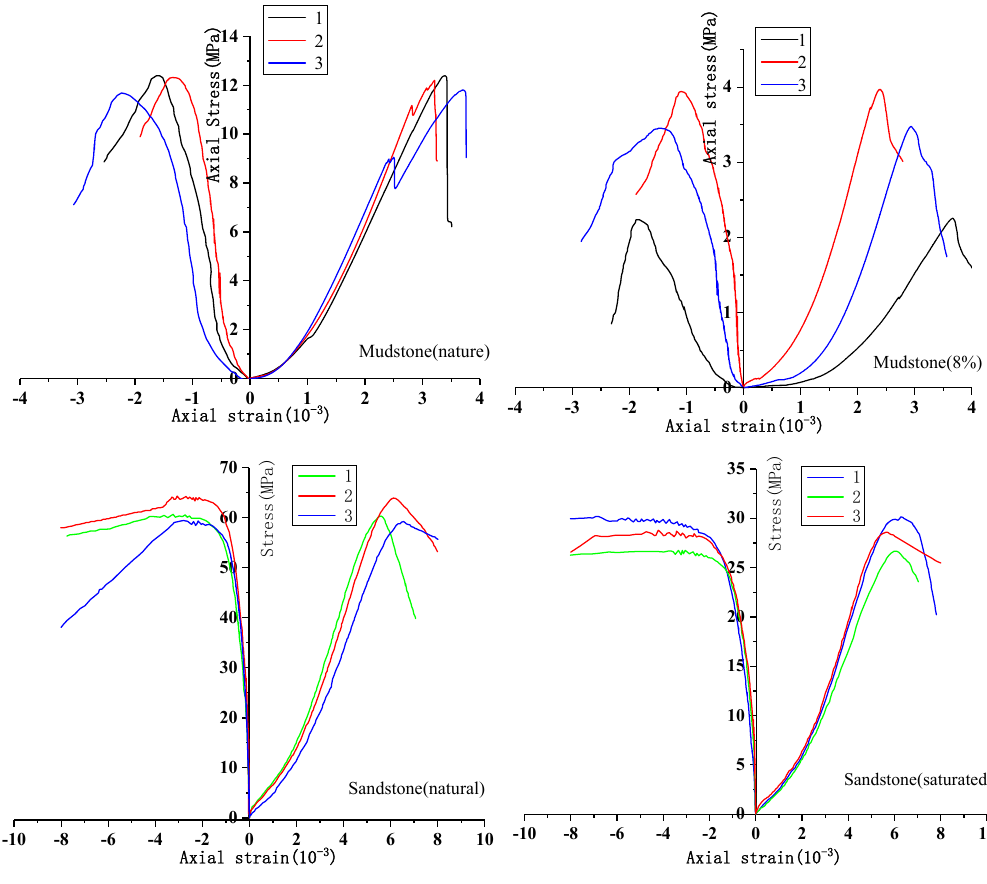
Figure 5. The whole stress–strain curve of rock. Figure 5 . The whole stress–strain curve of rock.